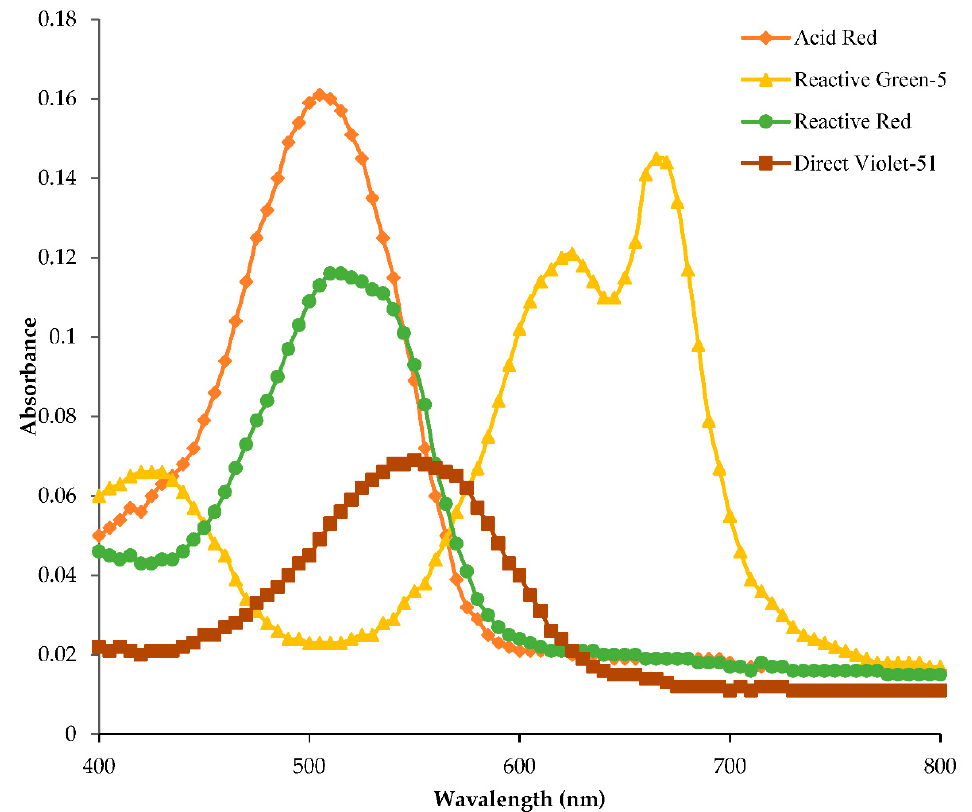
Figure 1. The determination of maximum absorption wavelengths for